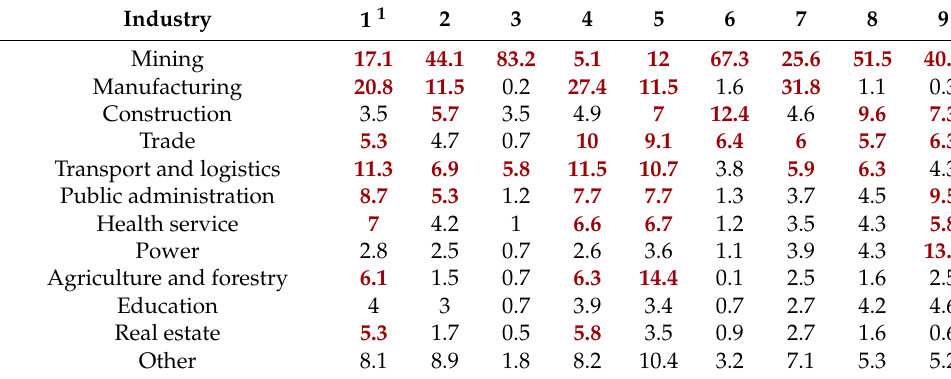
Table 5. The industries of economic specialization in the AZRF regions in 2018